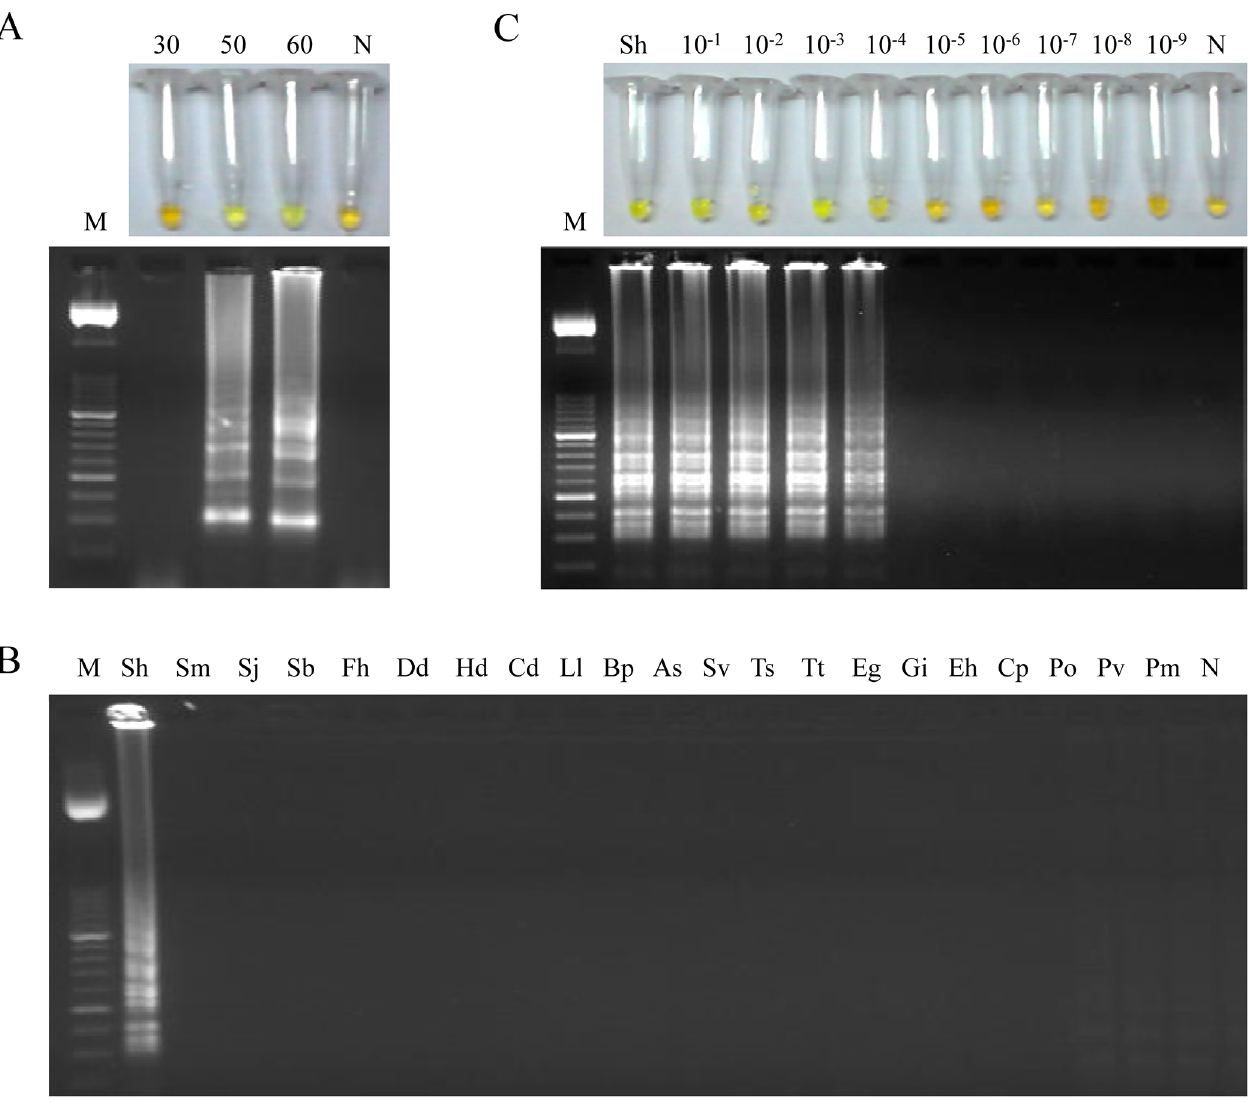
Fig 3. Setting up LAMP assay. (A) LAMP amplification results obtained at different incubation times (30, 50 and 60 min) tested in a heating block by the addition of SYBR Green I (up) or by visualization on agarose gel (down). Lane M, 50 bp DNA ladder (Molecular weight marker XIII, Roche); lanes 30, 50, 60, amplification results of S . haematobium DNA (1 ng) for 30, 50 and 60 minutes of incubation time, respectively. (B) Specificity of the LAMP assay for S . haematobium . A ladder of multiple bands of different sizes could be only observed in S . haematobium DNA sample. Lane M, 50 bp DNA ladder (Molecular weight marker XIII, Roche); lanes Sh, Sm, Sj, Sb, Fh, Dd, Hd, Cd, Ll, Bp, As, Sv, Ts, Tt, Eg, Gi, Eh, Cp, Po, Pv and Pm, S . haematobium , S . mansoni , S . japonicum , S . bovis , Fasciola hepatica , Dicrocoelium dendriticum , Hymenolepis diminuta , Calicophoron daubneyi , Loa loa , Brugia pahangi , Anisakis simplex , Strongyloides venezuelensis , Trichinella spiralis , Taenia taeniformis , Echinococcus granulosus , Giardia intestinalis , Entamoeba histolytica , Cryptosporidium parvum , Plasmodium ovale , P . vivax and P . malariae DNA samples (1 ng/each), respectively; lane N, negative control (no DNA template). (C) Sensitivity assessment performed with LAMP at 63°C for 50 min using serial dilutions of S . haematobium genomic DNA. Lane M: 50 bp DNA ladder (Molecular weight marker XIII, Roche); lanes Sh: genomic DNA from S . haematobium (1 ng); lanes 10 − 1 – 10 − 9 : 10-fold serially dilutions; lane N: negative controls (no DNA